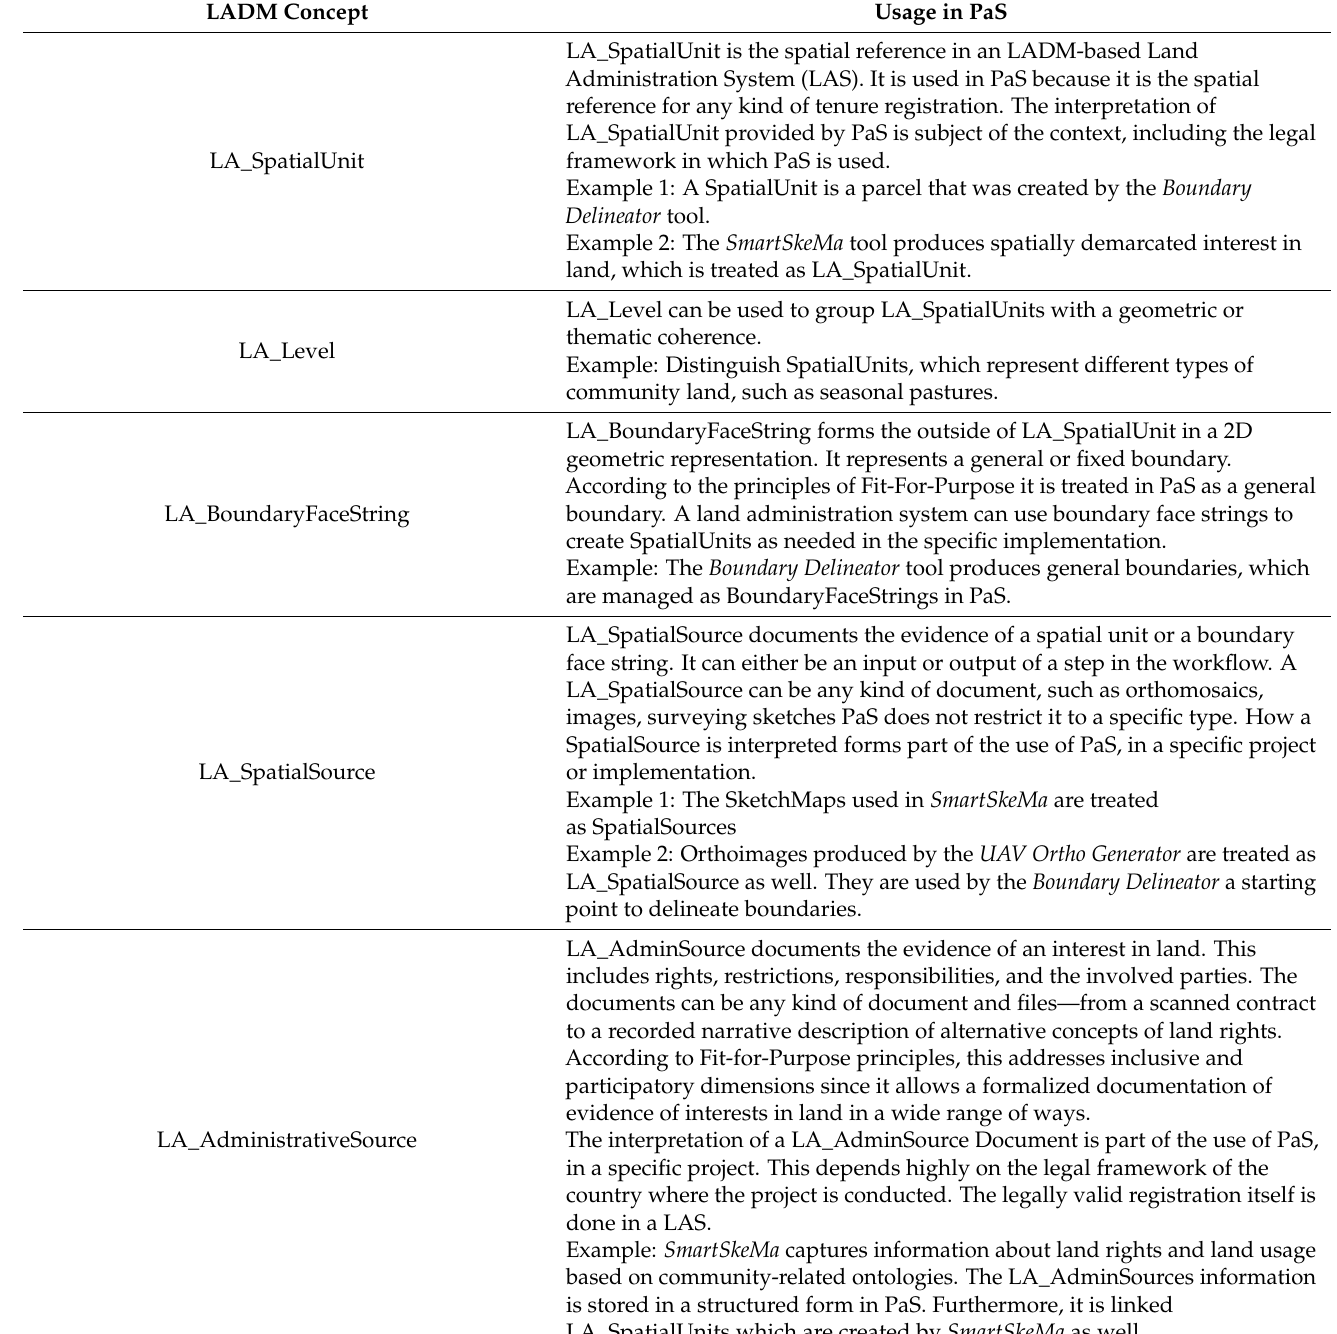
Table 1 below: Table 1. Concepts from LADM supported by PaS. LADM